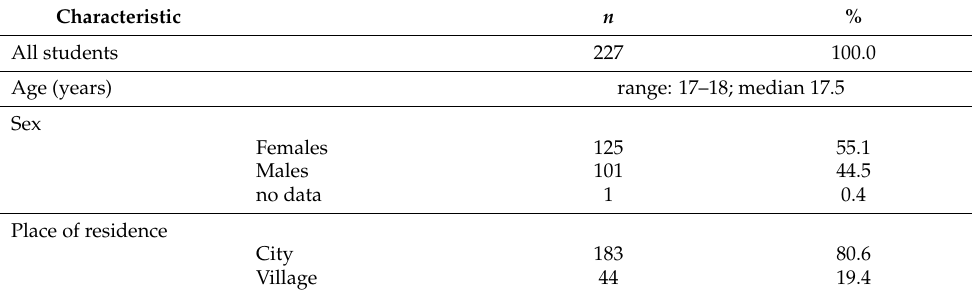
Table 1. Student’s